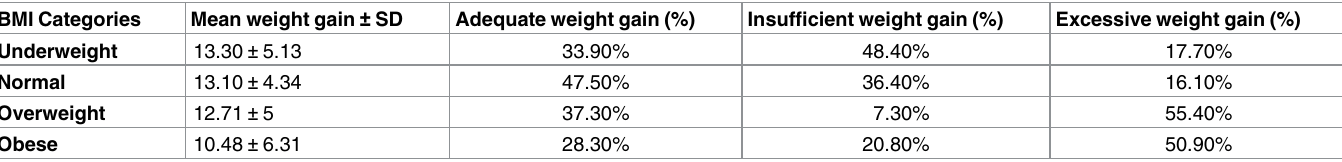
Table 3. Repartition of GWG of mothers according to their BMI (N =